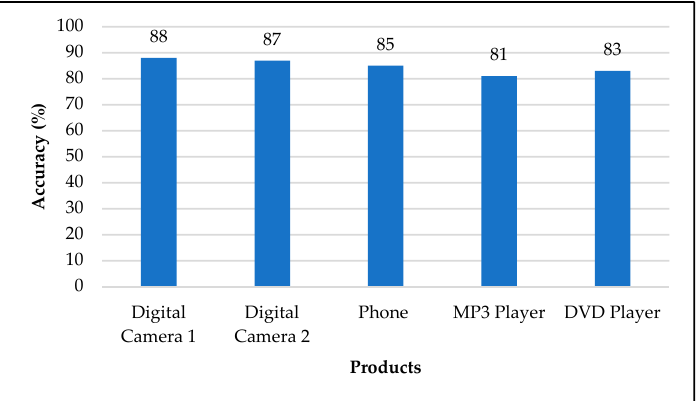
Figure 11. Accuracy of Reviews Quality Classification.